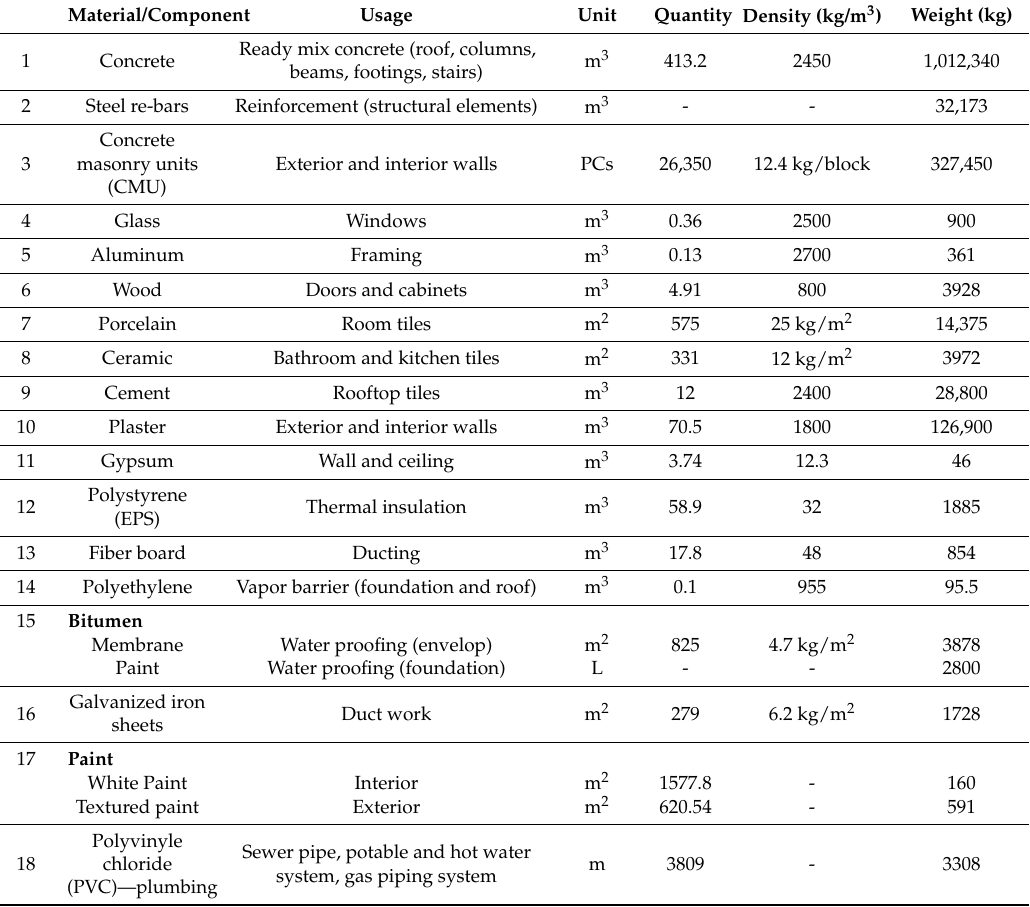
Table 2. Overview of building material